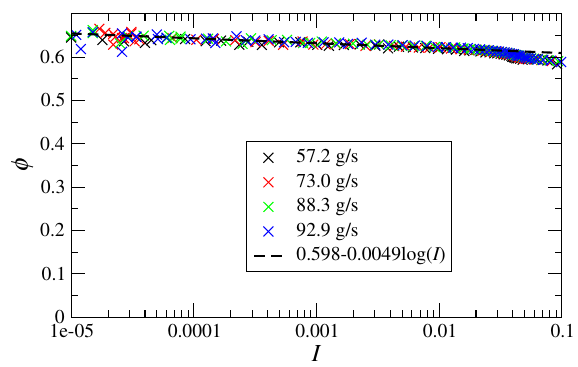
Figure 7. Variation of volume fraction ( φ ) with inertial number ( I